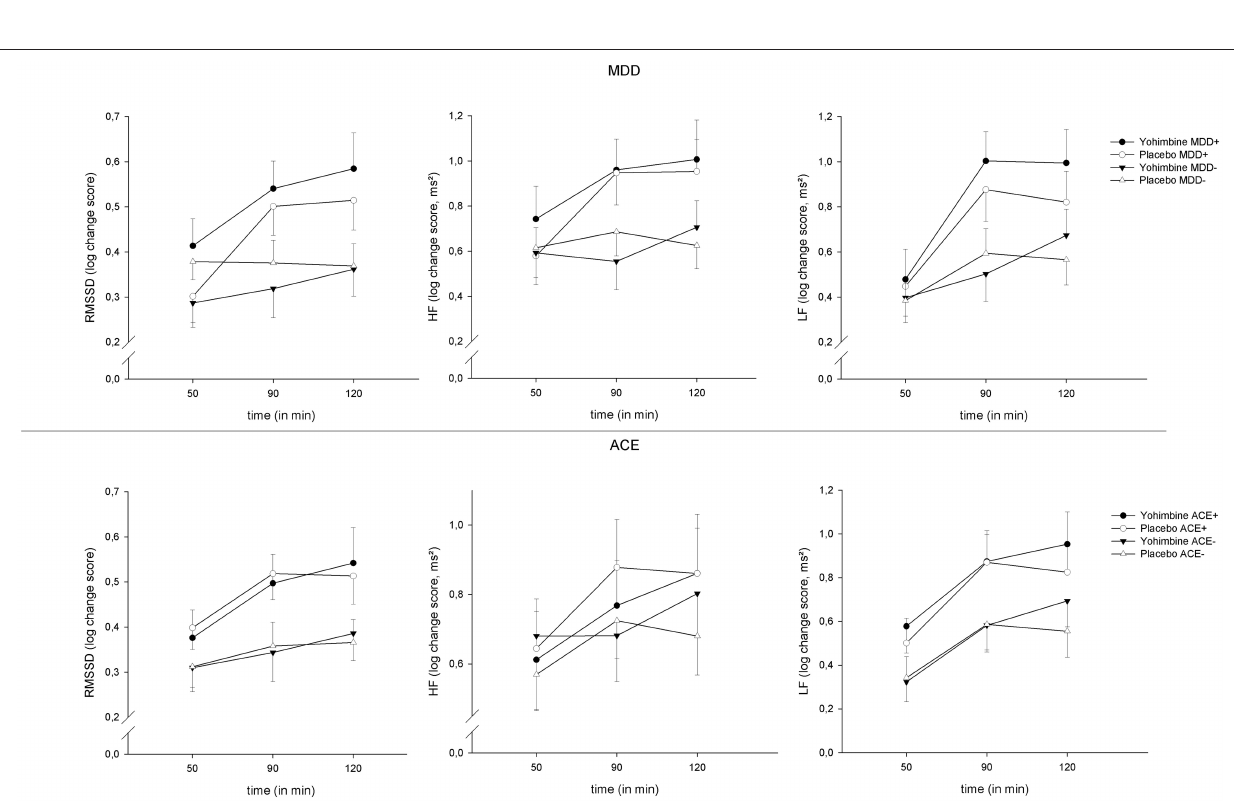
Frontiers in Psychiatry |